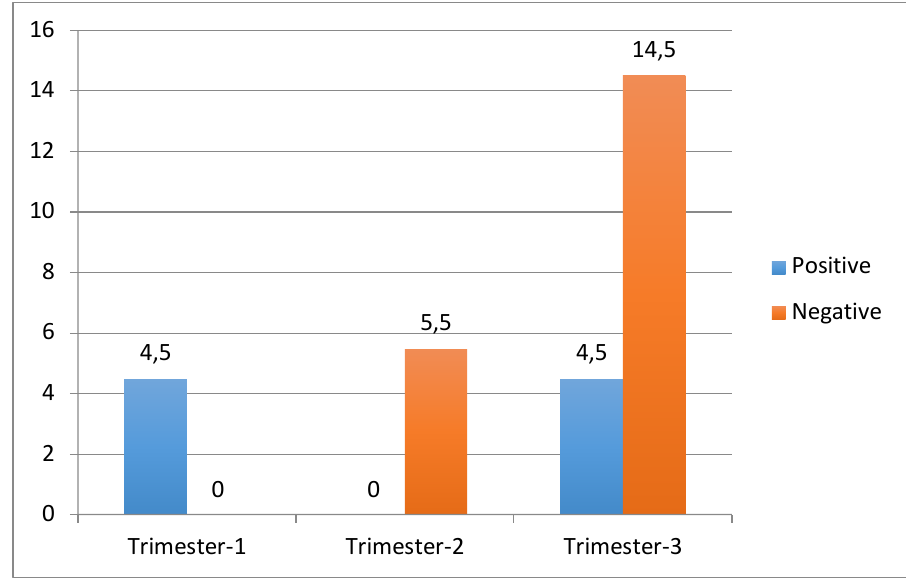
Proportions (%) of serum B insufficiency during pregnancy between groups 12 by trimester and the presence of fecal DR10 TM (no insufficiency status for folate and vitamin B 6